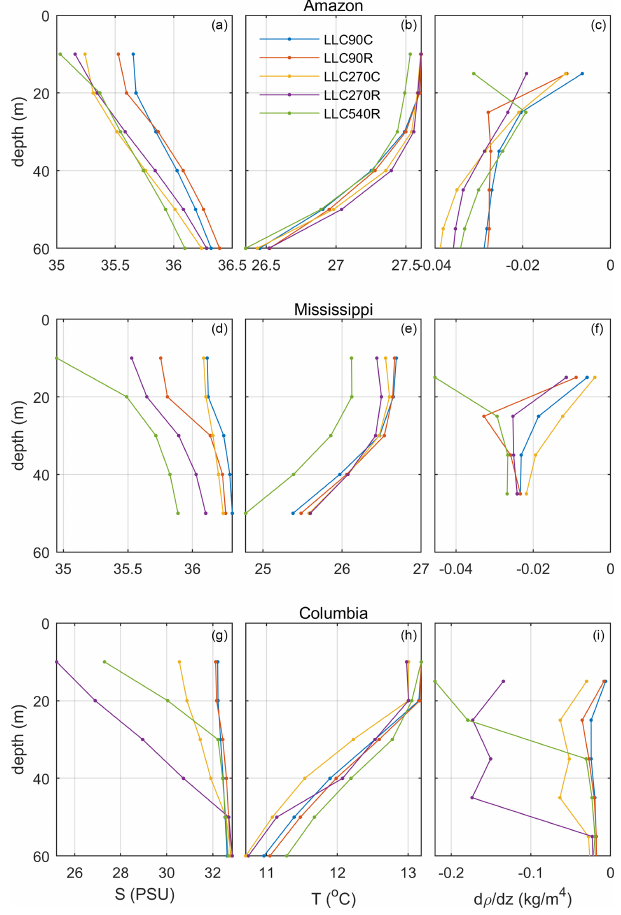
Figure 11. Mean 3-year (2015–2017) salinity, potential tempera- ture, and vertical density gradient (d ρ/ d z )